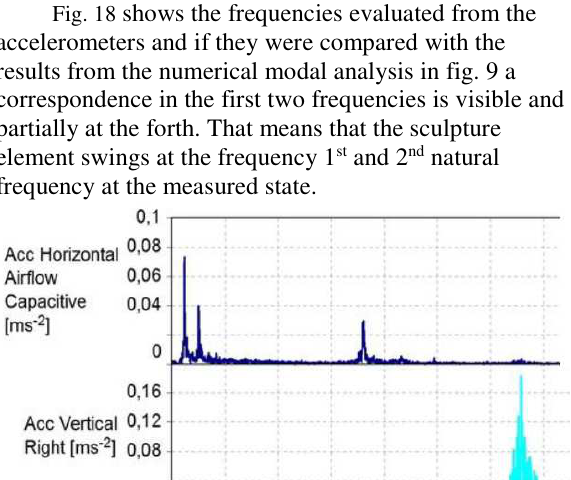
Fig. 17. Dependence between measured deflection (dot) and static numerical simulation one-way FSI simulation.